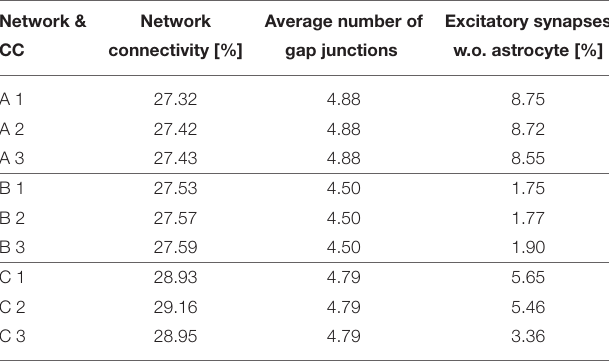
TABLE 2 | Different connectivity properties of the nine initial networks used in this paper. Network &